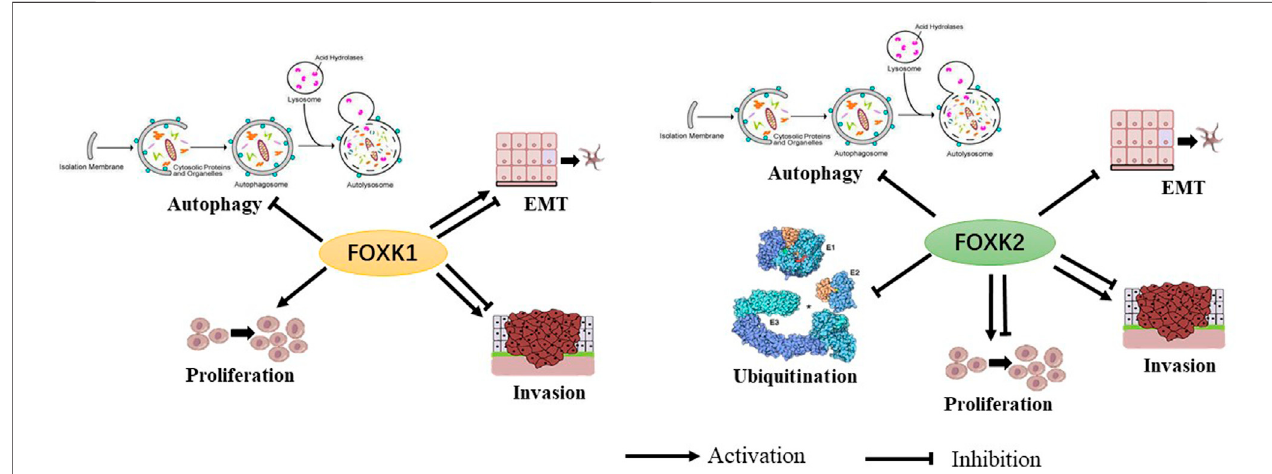
FIGURE 2 | The biological functions of FoxK1 and FoxK2 have been shown to have multiple permissive and inhibitory effects.